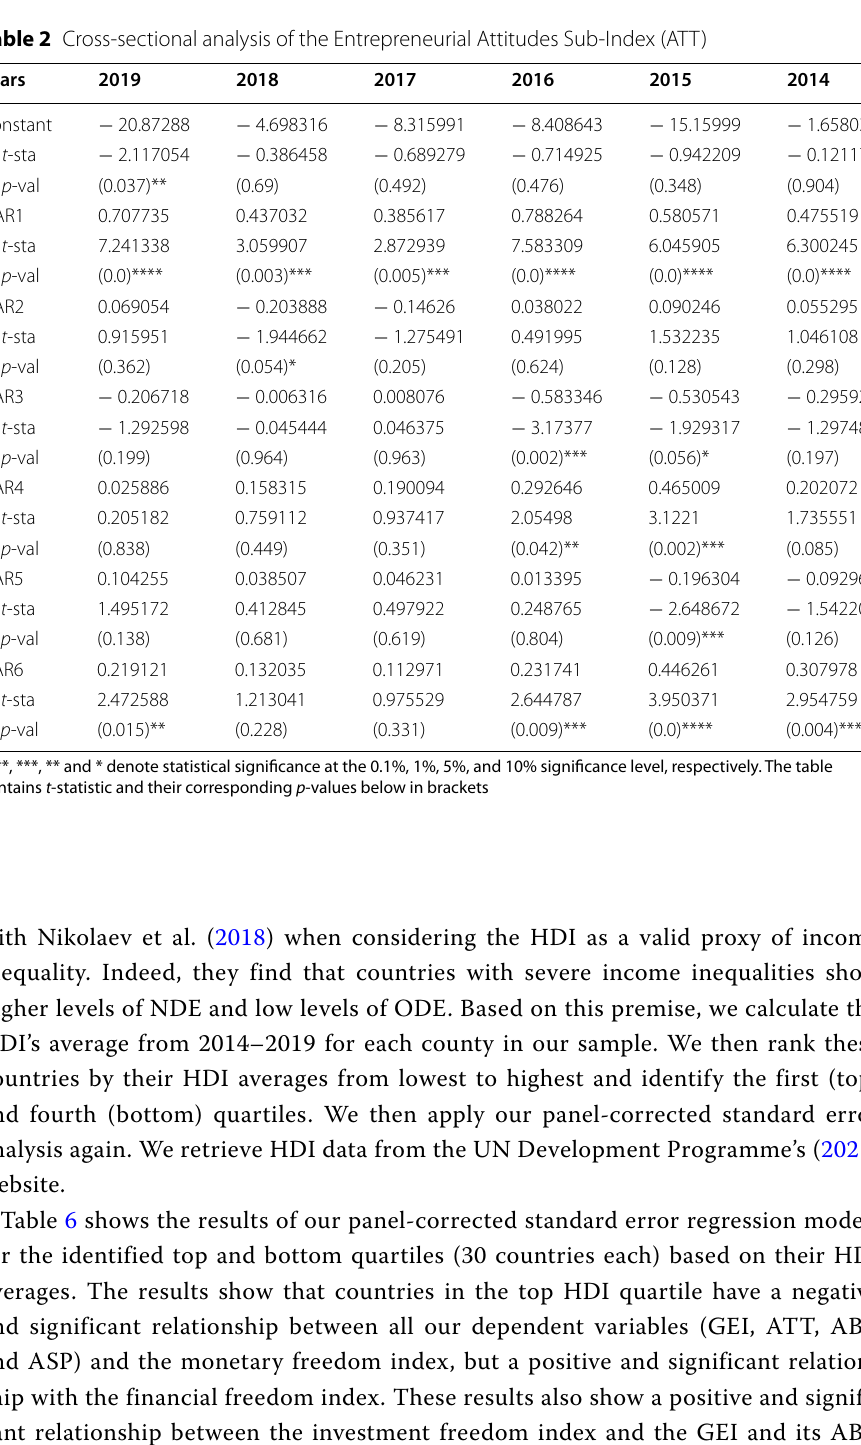
Table 2 Cross-sectional analysis of the Entrepreneurial Attitudes Sub-Index (ATT)